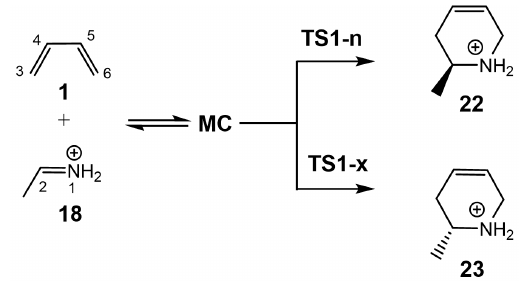
Table 3. ω B97XD/6-311G(d,p) relative electronic energies ( ∆ E, in kcal · mol − 1 ), enthalpies ( ∆ H,